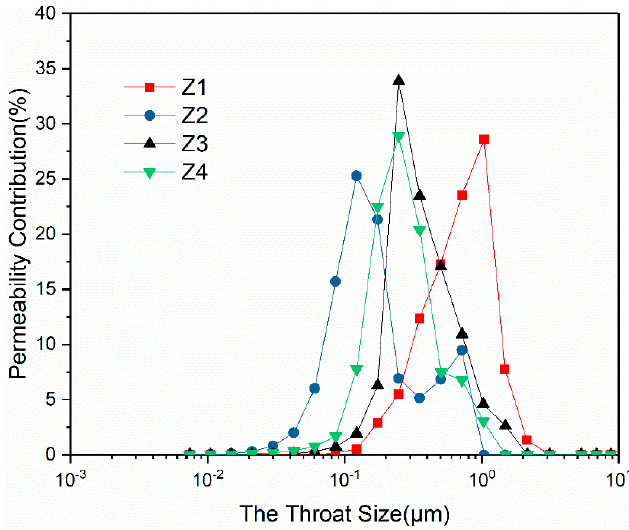
Figure 3. Relationships between throat size and permeability